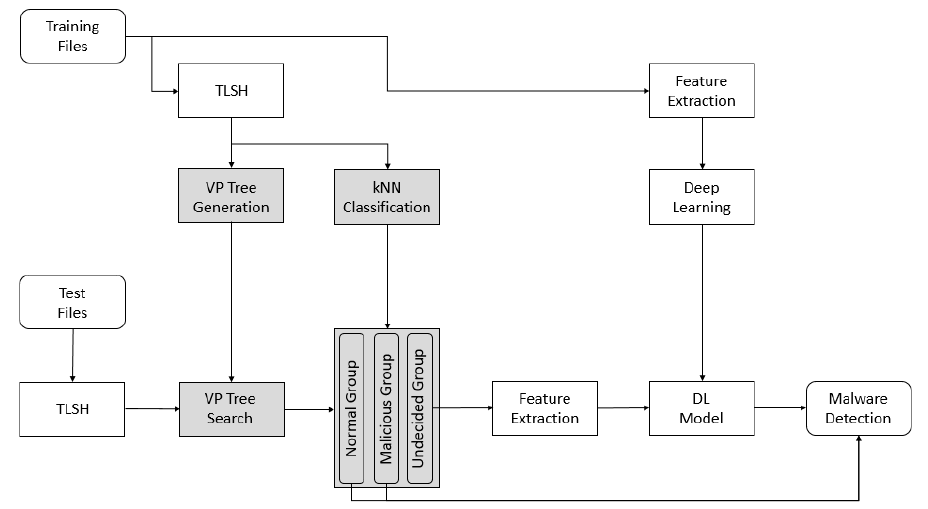
Figure 1. Proposed system for fast malware detection. TLSH: Trend Micro locality-sensitive hashing. VP: vantage-point. kNN: k-nearest-neighbor. DL: deep learning.